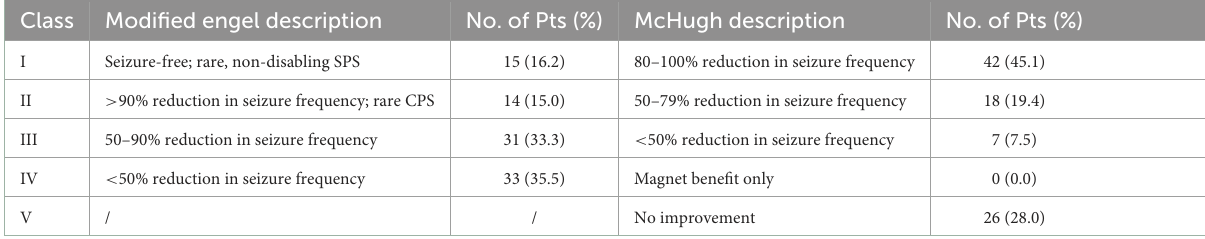
TABLE 2 Seizure outcomes evaluated by modified Engel and McHugh seizure outcome classifications at the last follow-up ( ≥ 1 year). Class Modified engel